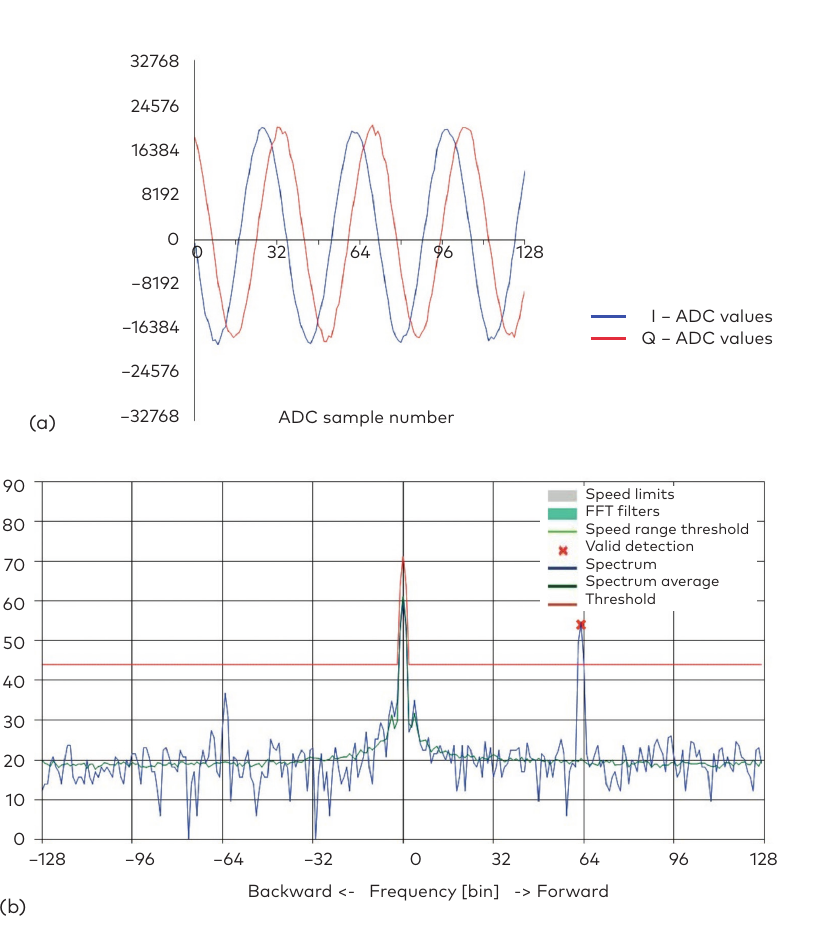
Figure 16. Radar transceiver signals: (a) I/Q signals; (b) complex FFT derived from I/Q signals (K-LD2)